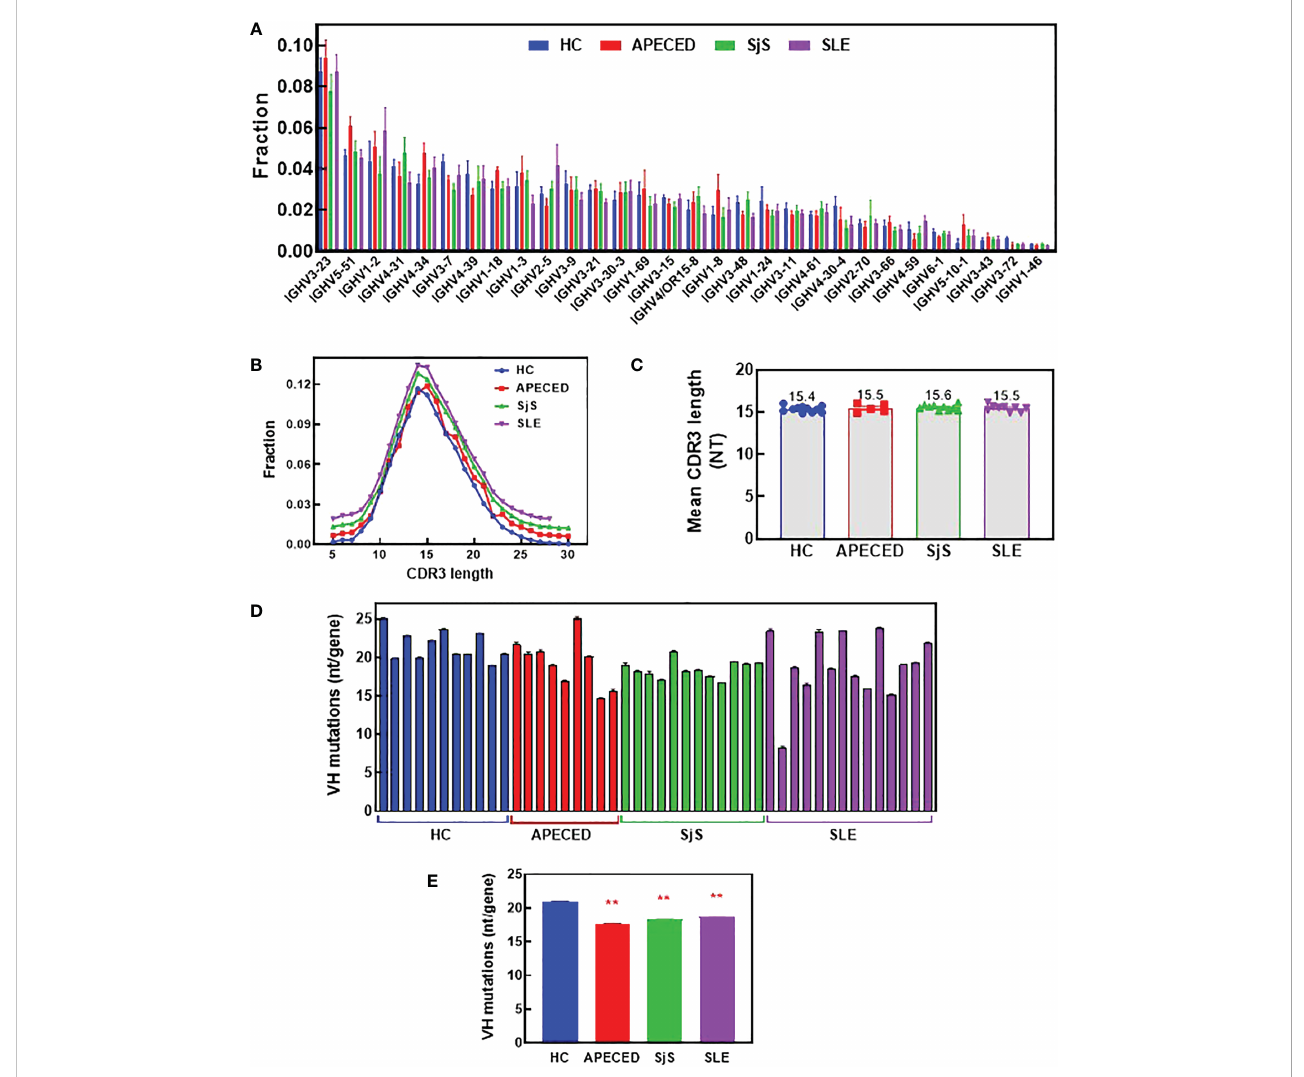
FIGURE 8 Analysis of VH gene family usage and CDR3 length. Switched memory B-cells were isolated from peripheral blood and RNA was puri fi ed for BCR sequencing. The relative frequency of VH gene sequences was determined and the mean was plotted for the top 30 most frequent VH genes for each group (A) . A Mann Whitney test with p value adjustment to account for multiple testing (FDR) was performed but no signi fi cant differences were found between groups for any of the genes. The CDR3 length distribution for all groups is plotted (B) and the mean CDR3 length for each subject was calculated and the group means are presented (C) . The number of mutations per VH gene was determined and the mean values are plotted for each individual (D) and the mean for the groups ± SEM (E) . A two-sided Mann Whitney U was run and found a signi fi cant difference between all the autoimmune groups and the HCs. ( ** signi fi cantly different from HC ANOVA p<0.01). APECED, autoimmune polyendocrinopathy – candidiasis – ecto- dermal dystrophy; BCR, B-cell receptor; CDR3, complementarity determining region 3; HC, healthy control; VH, immunoglobulin heavy chain variable region; SLE, systemic lupus erythematosus; SjS, Sjogren ’ s